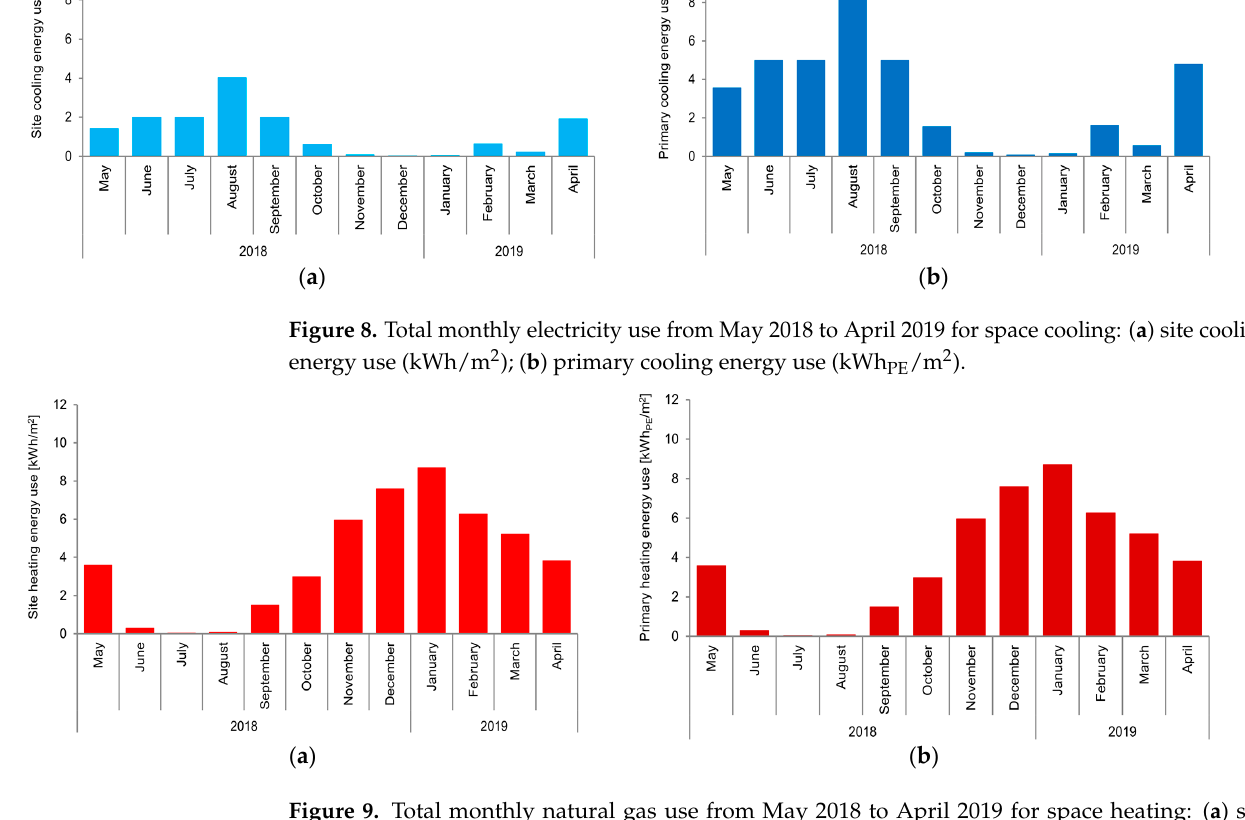
Figure 8. Total monthly electricity use from May 2018 to April 2019 for space cooling: ( a ) site cooling